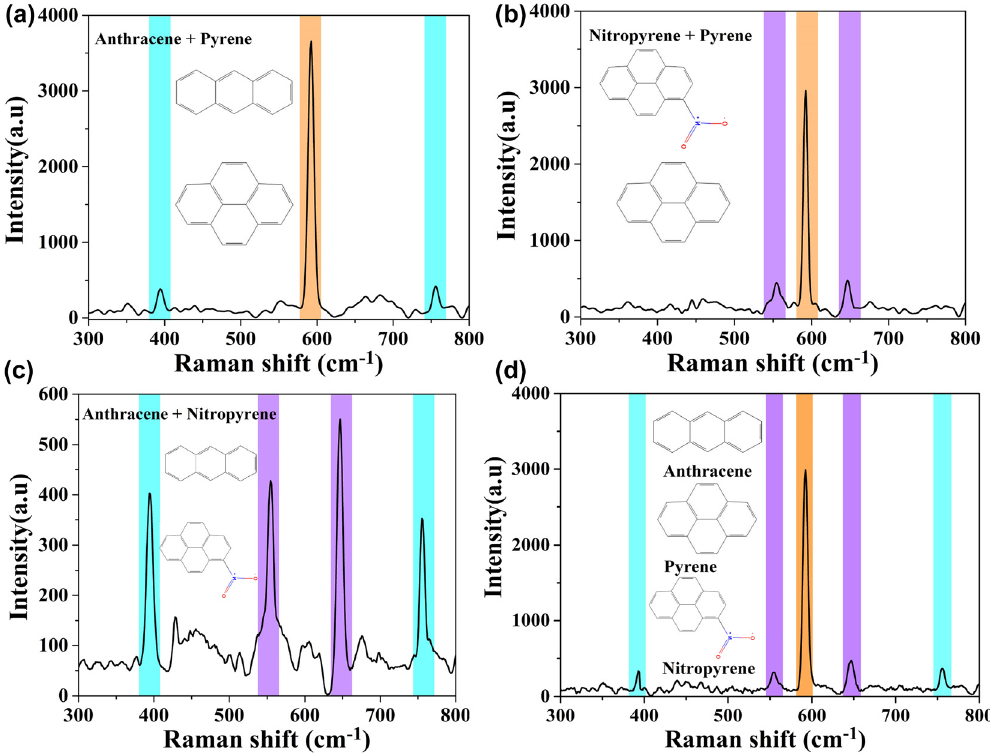
Figure 7: Liquid-NIR-SERS spectra of different mixtures with binary components: anthracene and pyrene (a), nitropyrene and pyrene (b), nitropyrene and anthracene (c), based on the double laser excitation of colloidal Au/Ag NUs. (d) Representative SERS spectra of aqueous ternary mixtures of nitropyrene (purple), anthracene (blue) and pyrene